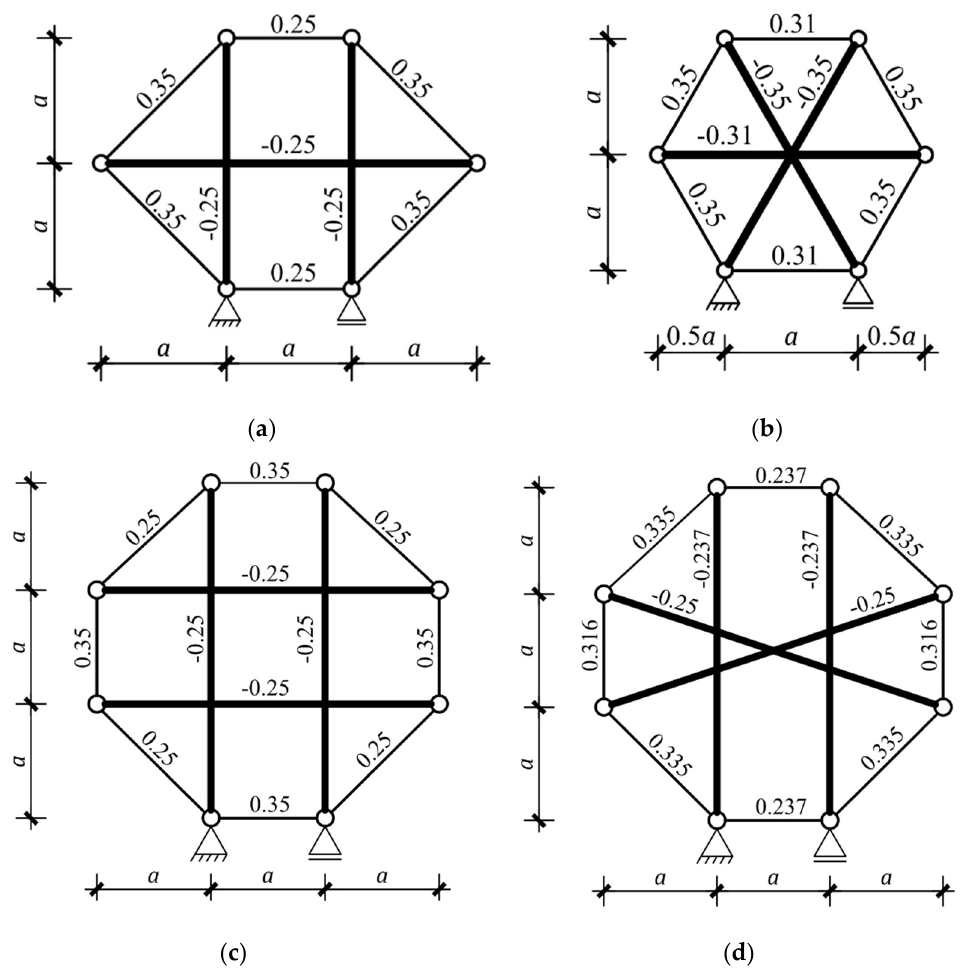
Figure 8. Values of self-stress state for four pure tensegrity trusses ( a - d ).